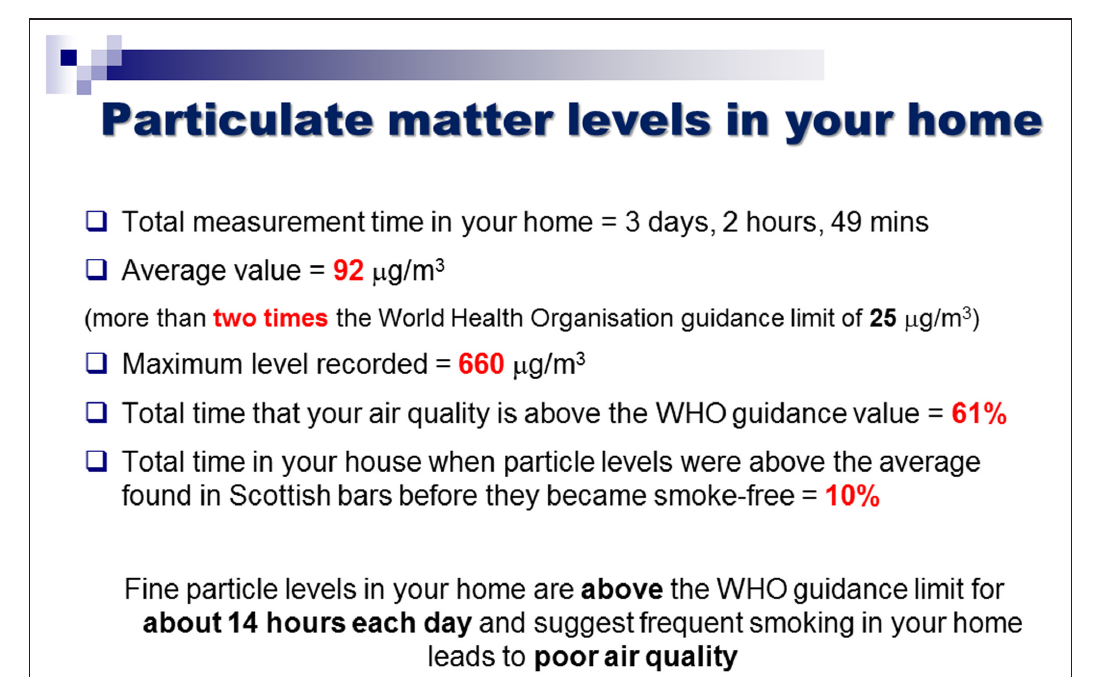
Figure 6: Examples of current feedback package at the time of the needs